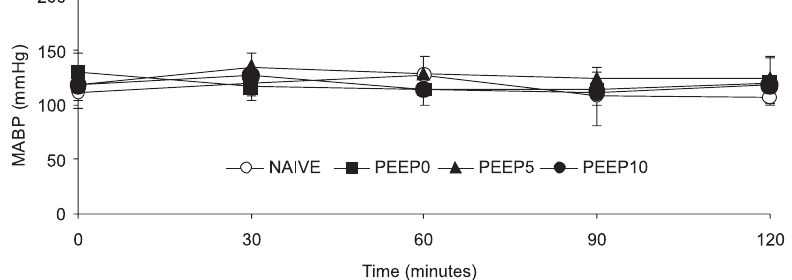
Figure 1 - Time course of mean arterial blood pressure (MABP) in NAIVE (n=9), PEEP0 (n=13), PEEP5 (n=12) and PEEP10 (n=13) groups showed no differences from baseline (0 h) up to 120 minutes of mechanical